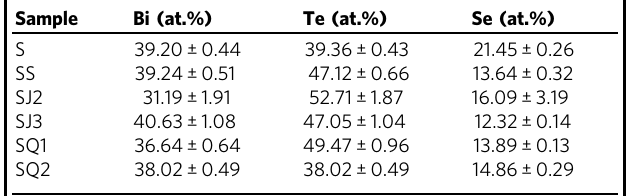
Table 2 Results of EDX